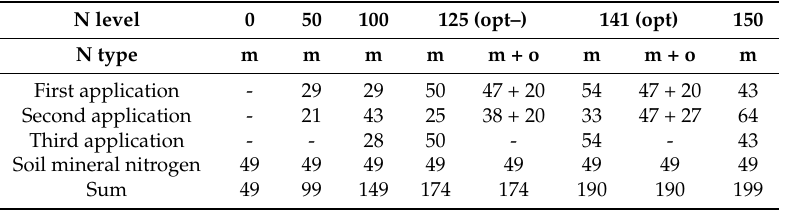
Table 2. Split fertilizer application rates in kg ha − 1 N according to different treatments. m: mineral optimal N fertilizer rate calculated following official recommendations; opt–: opt reduced by 10%. N